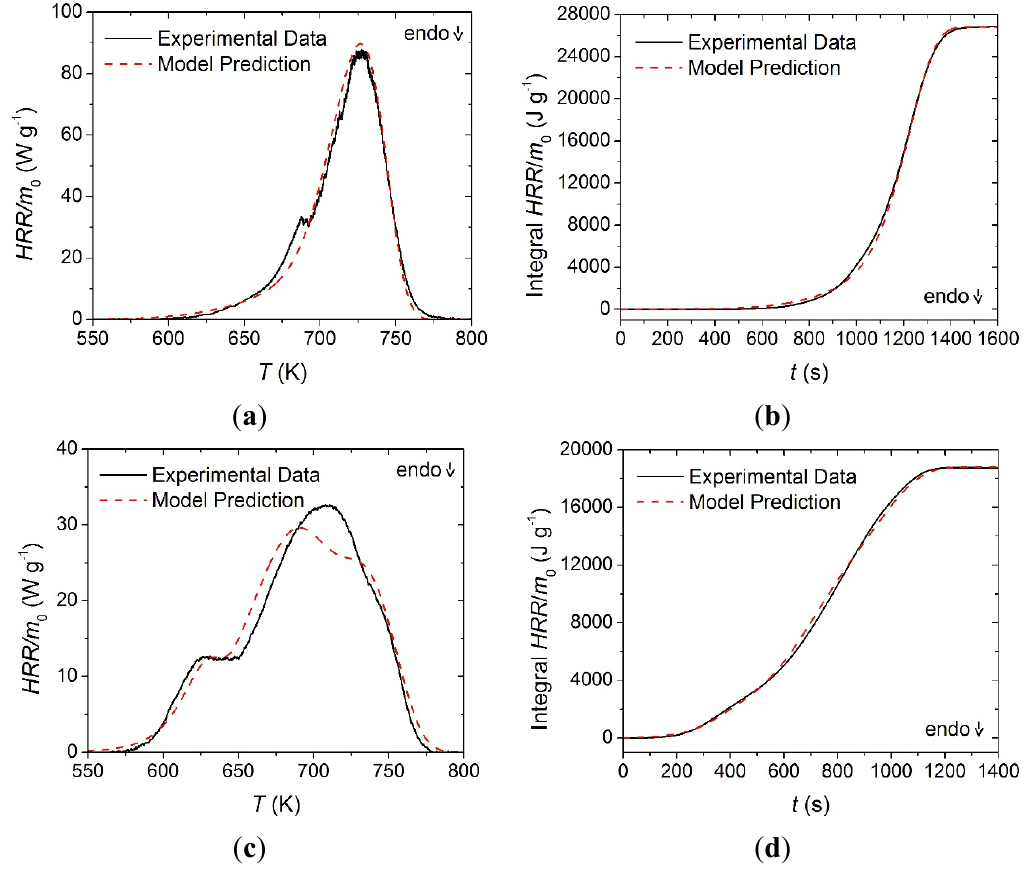
Figure 10. Cont Figure 10. Cont .